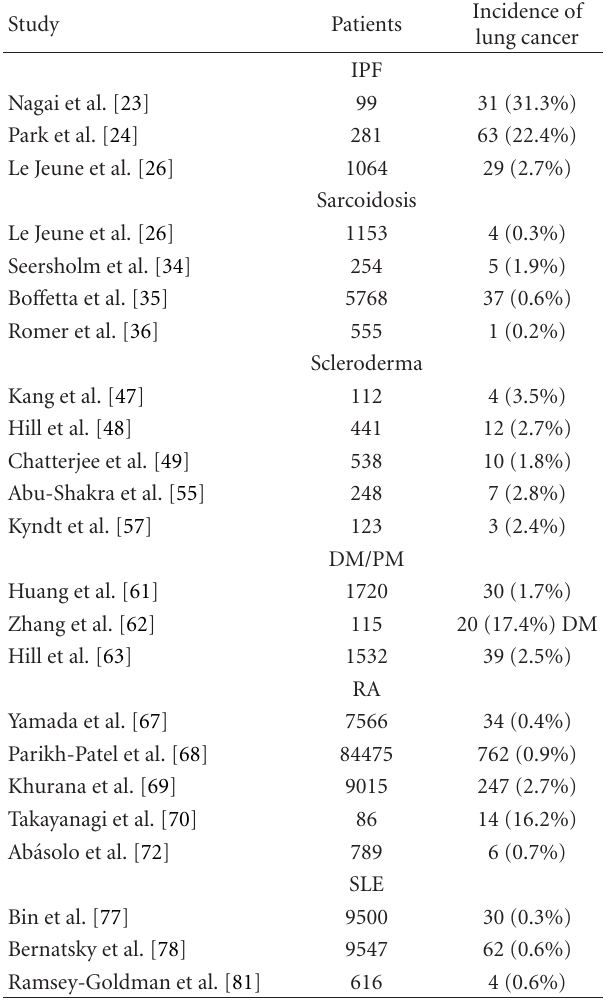
Table 1: Summary of the studies on incidence of lung cancer in interstitial lung